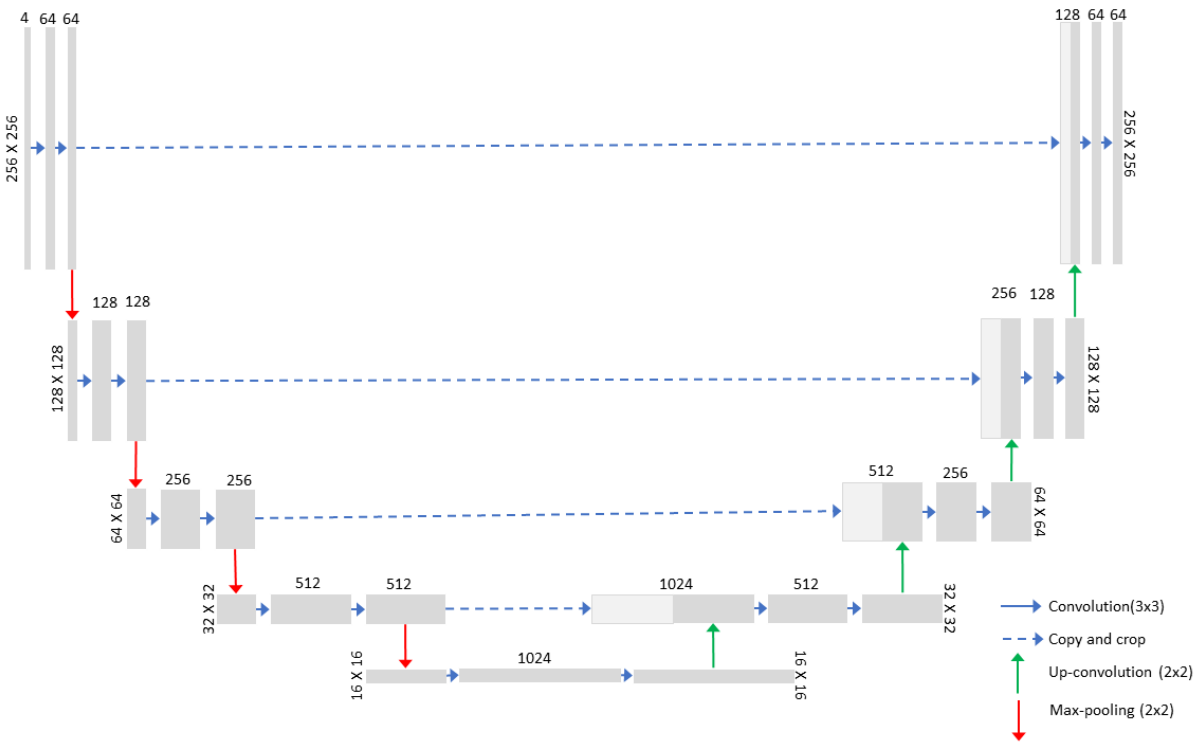
Figure 2. The U-Net architecture features a contracting path and an expanding path. The input data consist of four spectral bands of a WorldView-2 image.